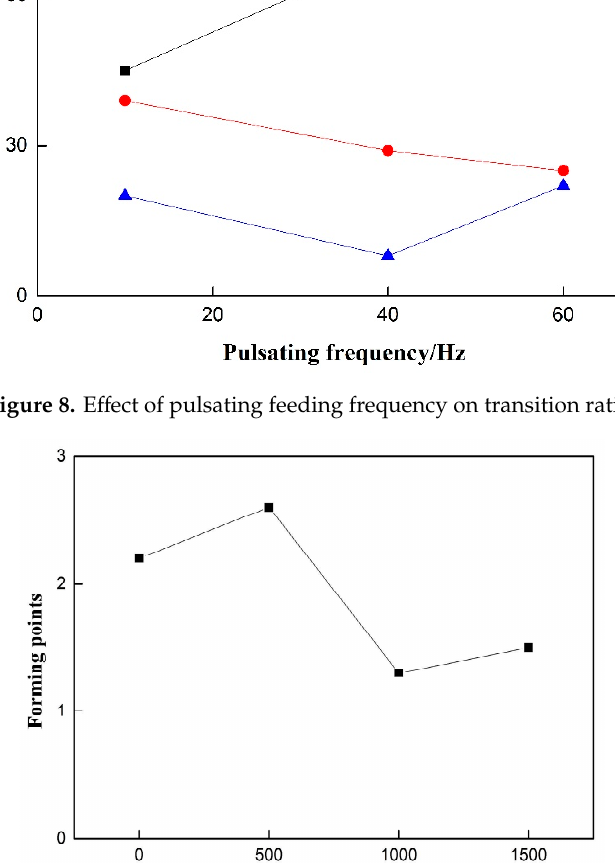
Figure 8. Effect of pulsating feeding frequency on transition ratio.